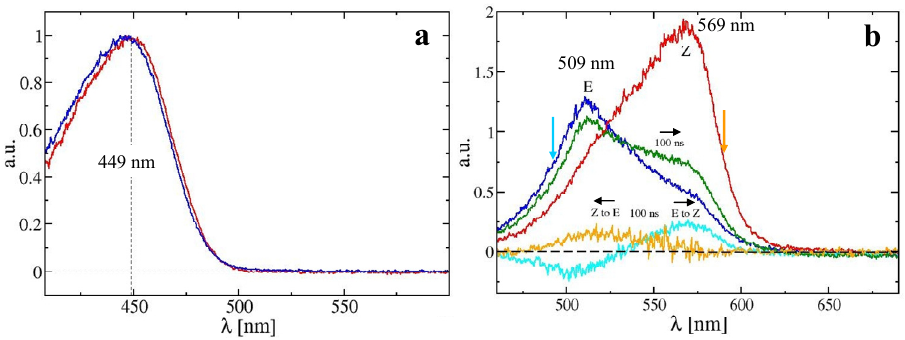
Figure 4. ( a ) Dark absorption spectra from PYP in solution (blue) and for a crushed single crystal (red) measured by the MSP. Spectra are recorded from 25 accumulations of 25 μ s exposures. The absorption maxima are at 446 nm and 449 nm in solution and crystal, respectively; ( b ) Dark absorption spectra for the E-state (blue) and Z-state (red) of α -PEC in solution and transient (difference) spectra after a short (6 ns) laser pulse. All spectra are obtained from 60 accumulations of 50 ns exposures. Green spectrum: 100 ns after the E-species is excited by a laser pulse at 490 nm (cyan arrow); Cyan spectrum: 100 ns difference spectrum (green minus blue); Orange spectrum: 100 ns difference spectrum after the Z-species is excited by a laser pulse at 590 nm (orange arrow, spectral change not shown). Direction of transition is shown by black